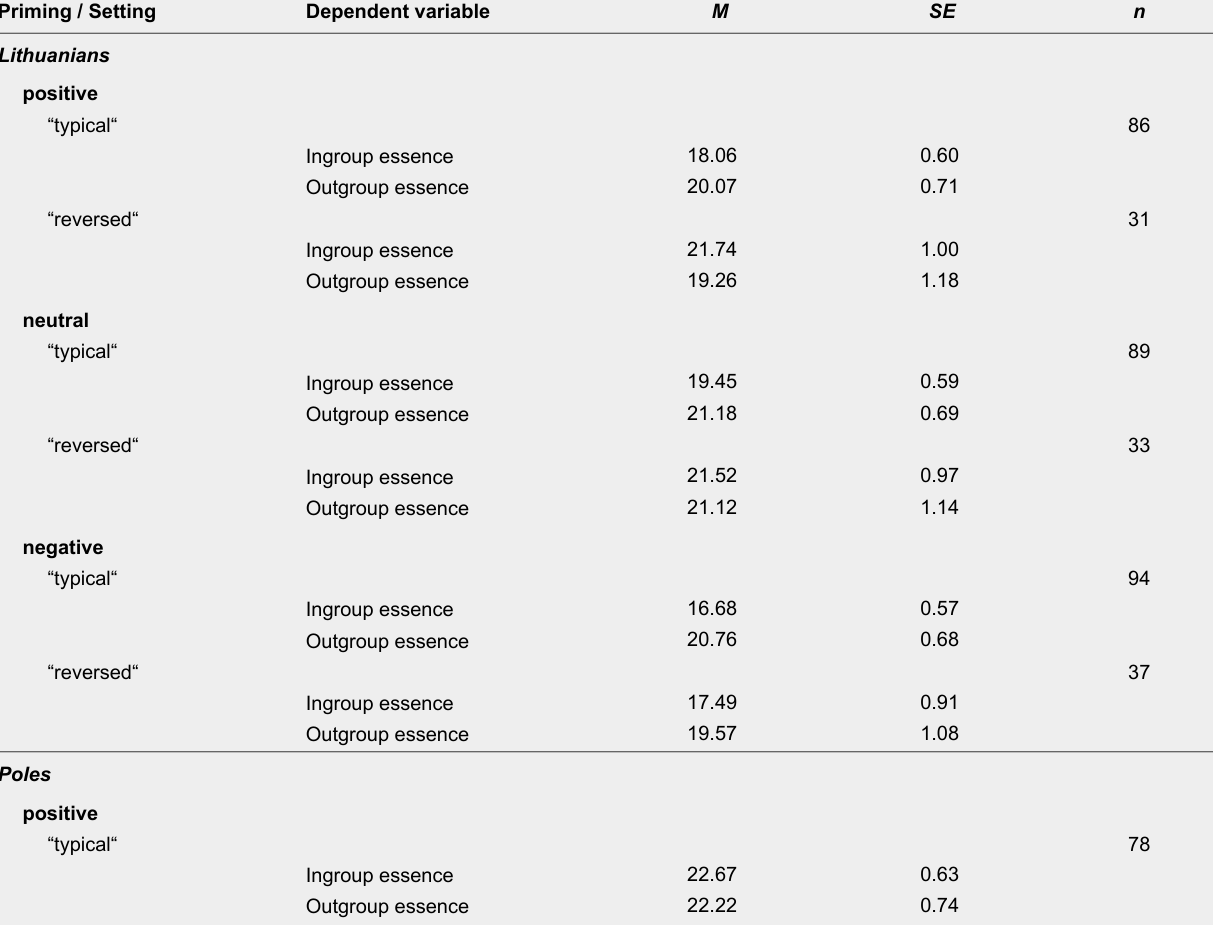
nSEM Dependent variablePriming /